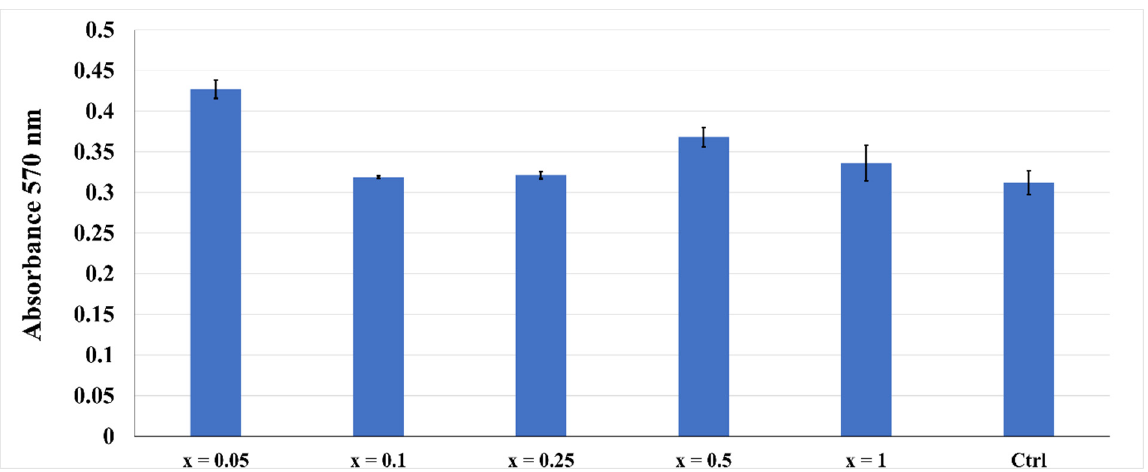
Figure 9. The viability of AFSC in the presence of the terbium-doped HAp by MTT assay. Glutathione (Figure 10) has a response for all terbium-doped nanomaterials similar to the control cells, indicating that the obtained nanomaterials do not induce cellular stress.